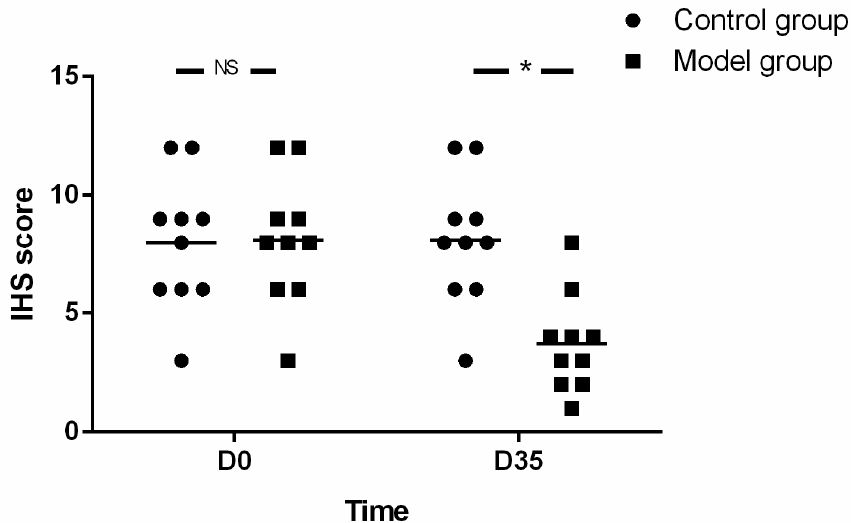
Figure 8. The expression of SOX-10. The expression of SOX-10 in model group was significantly reduced compared with that of control group at the end stage of the experiment. The number of mice in both groups was 10 at each time point. Unpaired two-tailed t -Test was used in comparison between groups and among different viewpoints in model group. IHS: immune-histochemical score. * p < 0.05, NS—not significant.